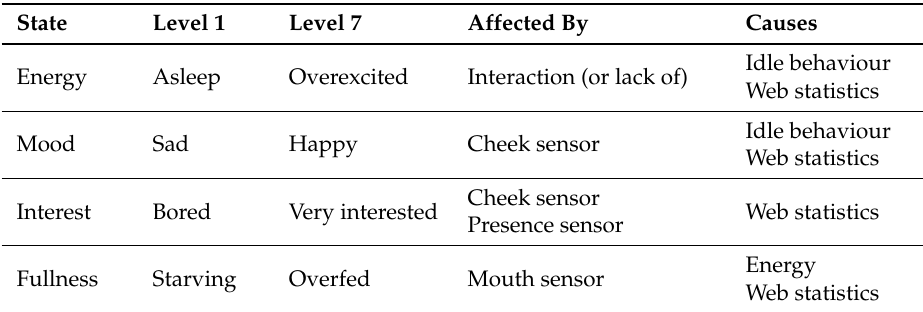
Table 2. The four emotive states used within Erica, together with the two ‘extreme’ cases, the inputs that affect them, and the outputs that are